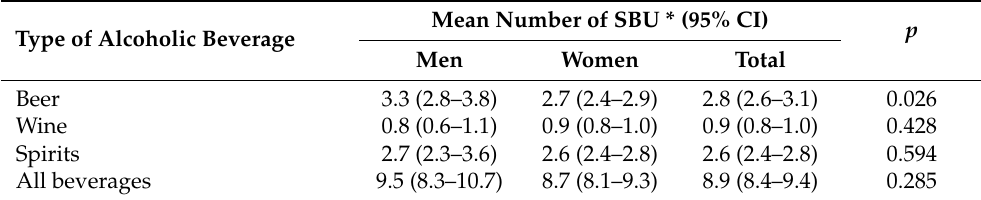
Table 3. Mean number of SBU per week among men and women, according to type of alcohol beverage (Student’s t